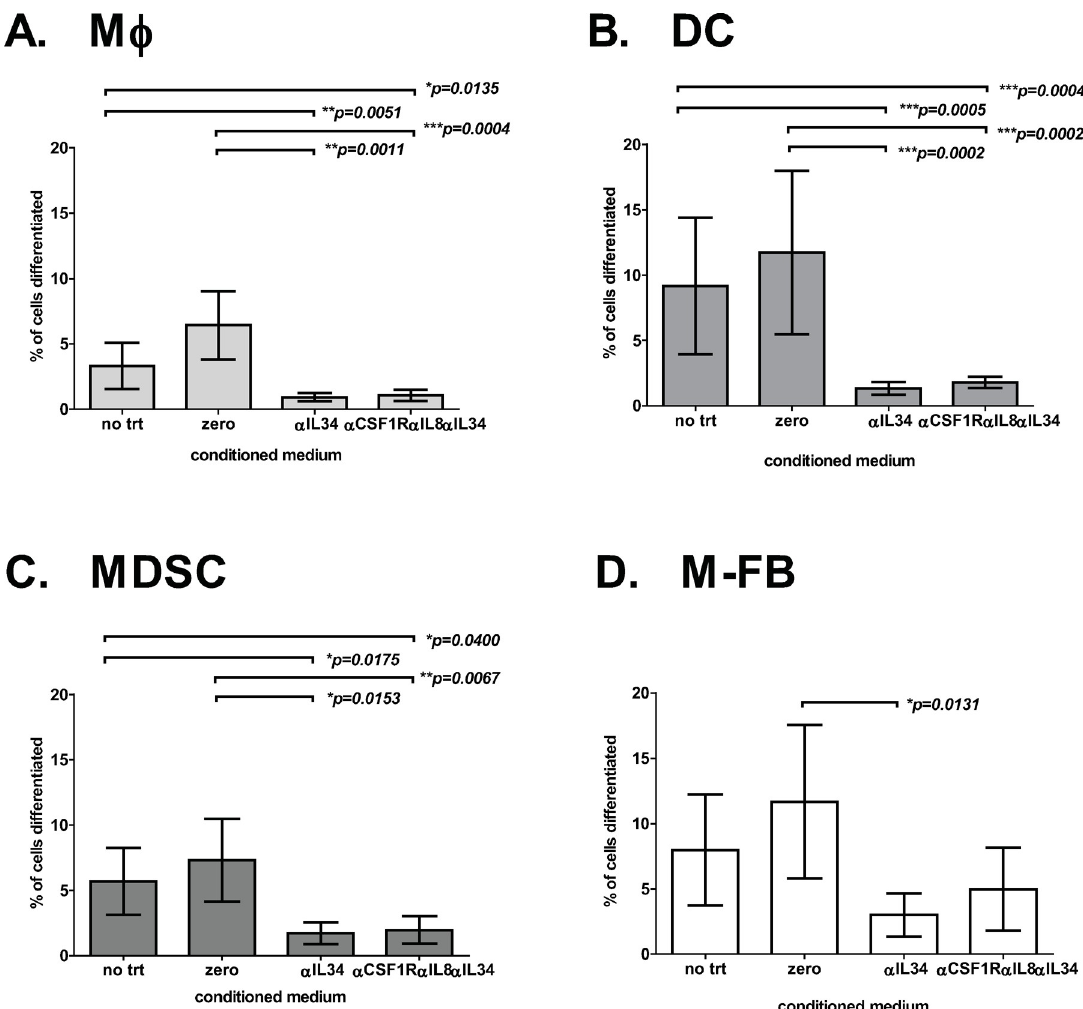
Fig 4. Myeloid precursor cell line U937 differentiation affected by PDAC PortalBMC conditioned media. Conditioned media collected from 8 PDAC patients’ 7-day PortalBMC cultures were used to stimulate myeloid differentiation in cultures of the human pre- myeloid cell line U937 (ATCC). The myeloid differentiation seen in U937 cells cultured for up to 7 days supplemented with conditioned media from PortalBMC cultures treated with 4mg/kg humanized anti-CSF1R (Cabiralizumab), 10mg/kg humanized anti-IL-8 (BMS- 986253) or 4mg/kg anti-IL-34 alone or in combination was compared to that seen in U937 cultures treated with media from untreated PortalBMC cultures ( zero ) and U937 cells cultured without conditioned media ( NO TRT ). Myeloid differentiation was determined by flow cytometry biomarker identification using the myeloid subpopulation profiles: ( A ) CD14+DR+ macrophages ( M φ ), ( B ) CD11c+DR +CD14- myeloid dendritic cells ( DC ), ( C ) CD14+CD33+DR-CD11c- myeloid-derived suppressor cells ( MDSC ), and ( D ) CD14+CD105 + Myeloid-derived fibroblasts ( M-FB ). Conditioned media from untreated cultures ( zero ) and humanized anti-CSF1R, humanized anti- IL-8 or anti-CSF1R+anti-IL-8 treated cultures did not statistically decrease the myeloid differentiation of U937 cells to Macrophage, Dendritic Cell, MDSC, and M-FB phenotypes. (data not shown) Conditioned media from PortalBMC cultures treated with anti-IL-34 alone or in combination with humanized anti-CSF1R and humanized anti-IL-8 significantly blocked myeloid differentiation in all ( A-C ) but ( D ) M-FB phenotypes. Conditioned media from PDAC PortalBMC cultures treated with anti-IL-34 inhibition alone significantly decreased the M-FB differentiation phenotype by compared to conditioned media from untreated ( zero ) cultures ( D ). PortalBMC culture anti-IL-34 conditioned media suppression of U937 M-FB differentiation was partially restored in U937 cultures supplemented with conditioned media from PortalBMC cultures treated with anti-IL-34 in combination with anti-CSF1R and anti-IL-8 ( D ). The statistically significant different p values for pairwise analyses of % phenotypic cells between treated and either untreated or ‘zero’ media- treated U937 cultures are listed above each graph with bars indicating the compared culture sets. Bars depict mean of values and error bars indicate standard error from the